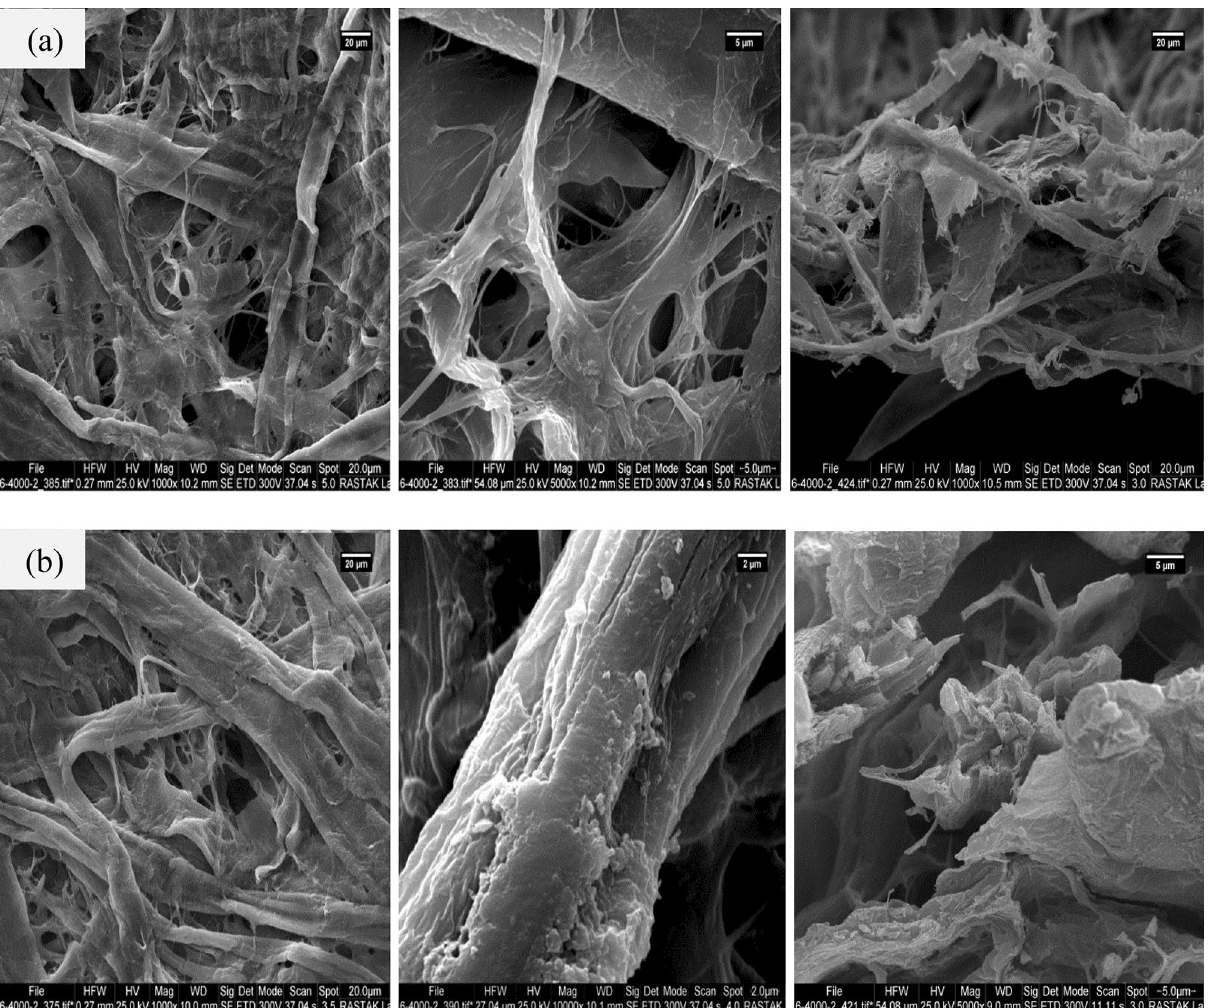
Figure 4. FE-SEM images of the (a) CS-FP, and (b) Cu@CS-FP. The images from left to right in order: low magnification, high magnification, and reaction 57–59 . The decomposition was occurred after 180 °C causing the 62.2% weight loss. The difference between the whole weight losses of CS-FP and Cu@CS-FP was about 28.8% which can be attributed to the Cu loading. In Fig. 7, the XRD patterns of the CS-FP, and Cu@CS-FP are shown. The CS-FP pattern indicated peaks at 2θ value of 14.8°, 16.5°, and 22.3° corresponding to the (1–10), (110), and (200) of the cellulose-I crystal structure (JCPDS. No. 03-0226) 17 . According to the literature, the peak at 34.1°, which appeared randomly, can be a com- posite of several reflections and (004) is not the dominant contributor 60 . By comparison of CS-FP, Cu@CS-FP, and cellulose patterns, CS may be coated in the form of an amorphous layer on the FP surface 17,18 . The physical modification does without the changes in the crystal structure of cellulose. The XRD pattern of the Cu@CS-FP was showed a Bragg reflection at 2θ = 27.1°, which was absent in the XRD pattern of the CS-FP. This peak is indexed as (111) and probably related to the face-centered cubic structure of Cu. Due to the low content of the Cu in the Cu@CS-FP strip, the rest of the peaks of Cu were not observable in the pattern. The catalytic activity of Cu@CS‑FP dip catalyst for ATRP reaction. To investigation the efficiency of Cu@CS-FP, the ATRP reaction of methyl methacrylate in the presence of ethyl α -bromoisobutyrate (EBiB) initiator and toluene solvent as a model reaction. The reaction was performed in the presence of various amounts of the catalyst (Table 1). For a better comparison, the molar ratio of monomer to initiator was considered similar in all experiments. When the experiments were carried out in the absence of dip catalyst, the reactions failed to produce any polymer even after 48 h (Table 1, Run 1). Hence, the presence of Cu@CS-FP dip catalyst in the ATRP of MMA is essential, and polymerization drove by it. With increasing the amount of catalyst at 24 h reac- tion time, the monomer conversion increased significantly from 9 to 68%, and polydispersity tended to narrow from 1.51 to 1.32 (Table 1, Run 2–4). A further increase in the amount of catalyst had the opposite effect, and only 19% conversion was achieved even after 30 h of reaction (Table 1, Run5). The experiments with the optimal